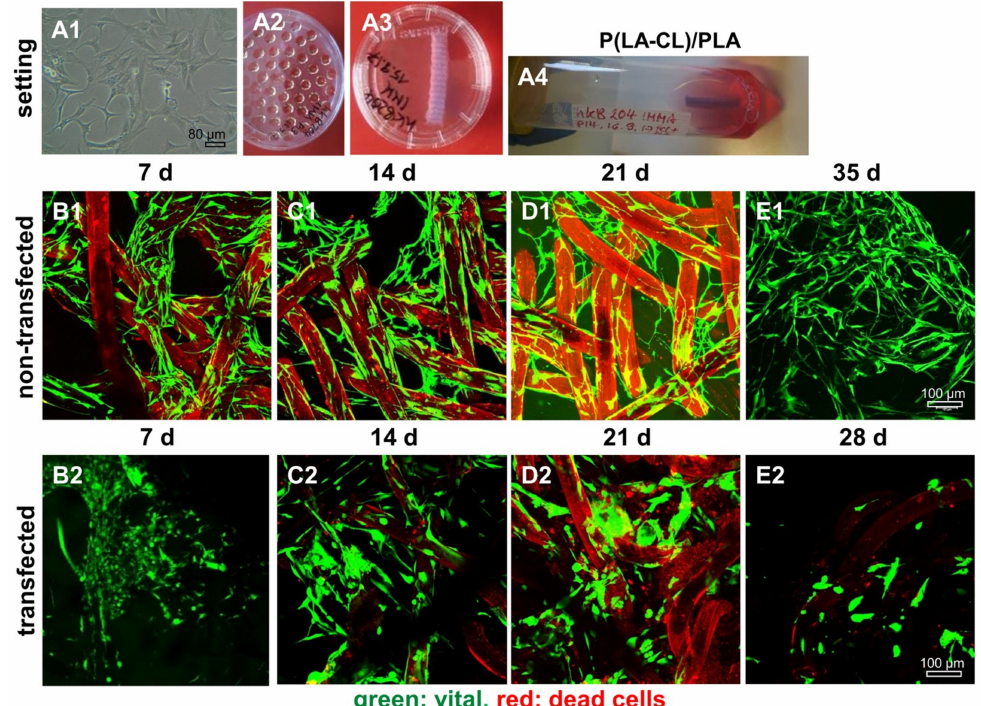
Figure8. Representativemicroscopicfieldsofnon-transfectedandSV40transfectedACLligamentocytes on P(LA-CL) / PLA sca ff olds. Experimental design, cell expansion ( A1 ); self-assembly using hanging drop method (50,000 cells per spheroid) ( A2 ); macroscopic image of wet P(LA-CL) / PLA sca ff olds ( A3 ); and dynamical rotatory sca ff old culture ( A4 ). ( B1 – E2 ) Live / Dead staining of cultures maintained up to day 35 (non-transfected cells, ( B1–E1 )) and day 28 (SV40 transfected cells, ( B2–D2 )). Vital cells: Green. Dead cell: Red. Sca ff old fibers: Slightly red colored. Three independent experiments were performed. Scale bars: 100 µ